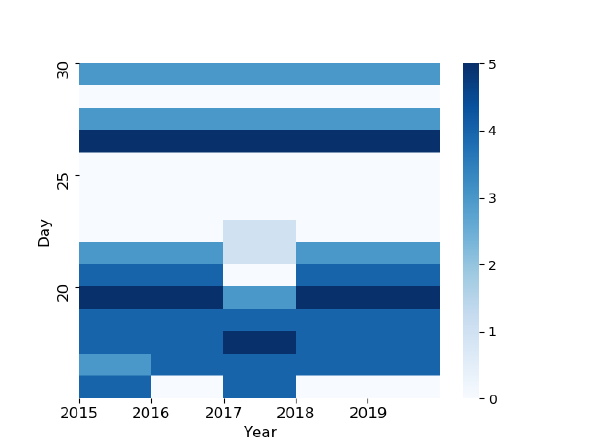
Figure 23: Clustering output for humidity for last 15 days in Q 1 over 2015 to 2019.